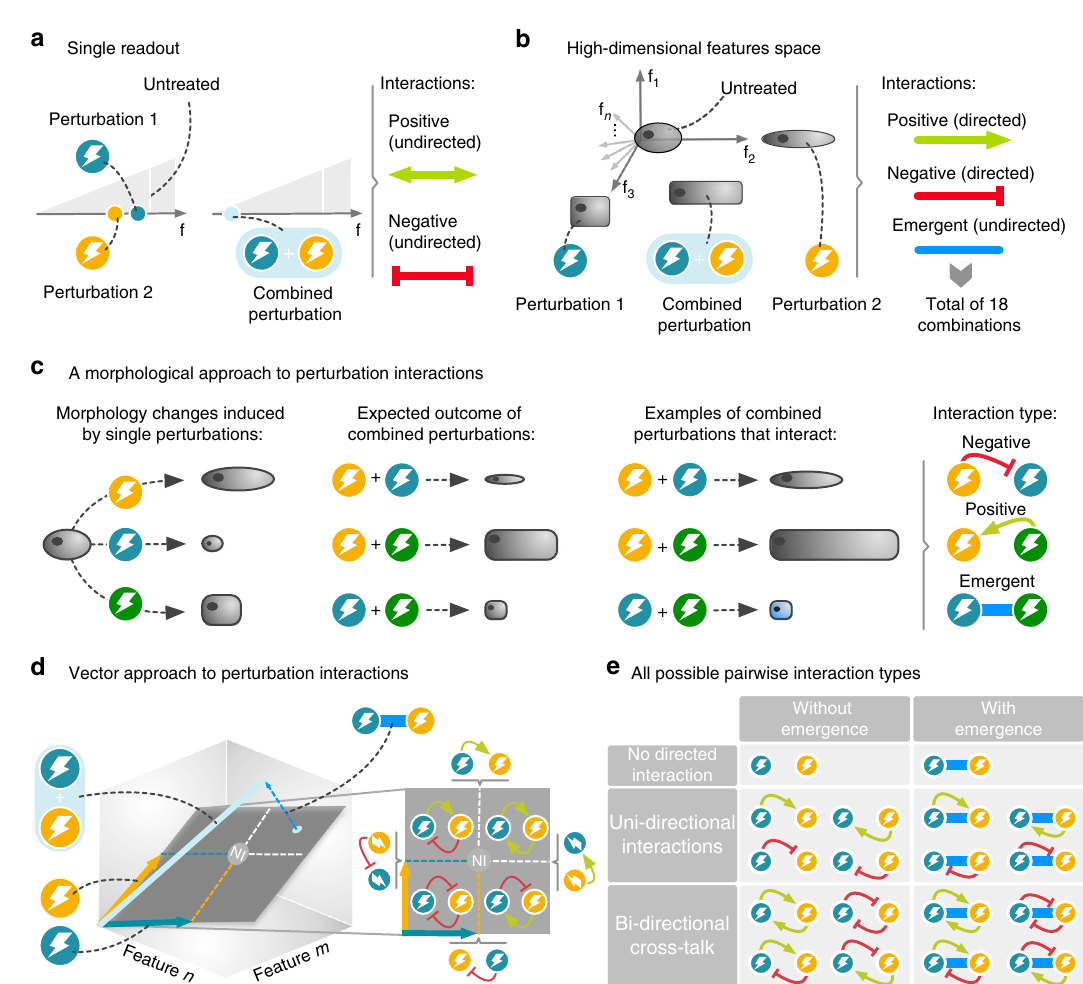
Fig. 2 Mathematical framework for a complete description of pairwise perturbation interactions. a Single readout measurements (number of features f = 1, e.g. cell viability) can only distinguish three interaction types between perturbations: positive, negative (e.g., synergy/antagonism), or non-interaction. b High-dimensional readouts ( f > 2, e.g. cell morphology), enable the identi fi cation of two directed interaction types (positive and negative), describing whether the effect of a perturbation was increased or decreased, as well as one undirected type, describing emergent features that are not present in any of the individual perturbations. c Each perturbation (i.e., drug treatment) is associated with a speci fi c cell phenotype. When two perturbations are combined, we identify the superposition of their individual effects as non-interaction, and any deviation as interaction, respectively. d Perturbations can be represented as vectors in the high-dimensional feature space, pointing from the unperturbed to the perturbed state. Two perturbations span a 2D plane S , which also contains the expected non-interaction (NI) phenotype. The NI point divides S into four quadrants that can be identi fi ed with different interaction types. Any measured phenotype of two combined perturbations can be decomposed into two components within S , which determine the directed interactions, and a third component perpendicular to S , indicating the emergence of entirely new features. e Summary of all 18 possible interaction